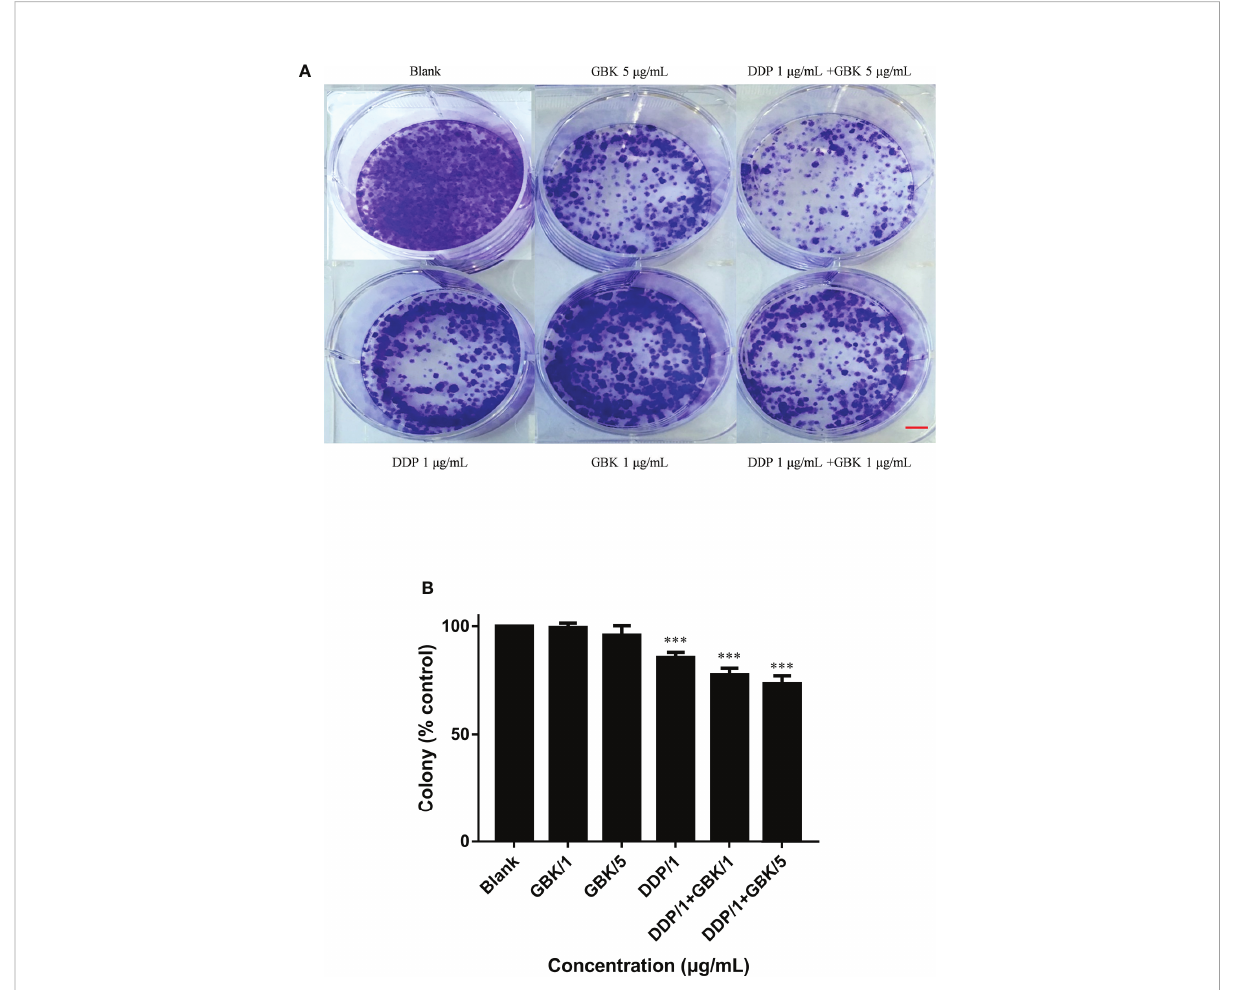
FIGURE 6 Combination treatment with GBK and DDP impairs the independent viability of breast cancer cells. The effect of combination treatment on the colony formation of breast cancer cells was analyzed. (A) Cell viability was determined by crystal violet staining of SUM-159 cells. (B) Quanti fi cation of the results in (A) . Data are presented as mean ± s.e.m. of three independent experiments. Student ’ s t test, *** p<0.0001. Scale bar represents 2.5